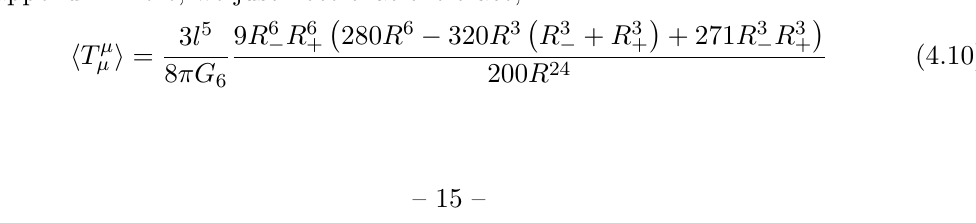
Figure 4. (a){(c) are plots of the four dimensional 4 (cid:25)G 5 of R (cid:0) =R + . In the plots, the thick line is the energy density T t dashed line is T (cid:10) . In (d), we plot the energy densities for R (cid:0) =R + = 0, .2, .5, .9, and 1.0 (black (cid:10) dotted